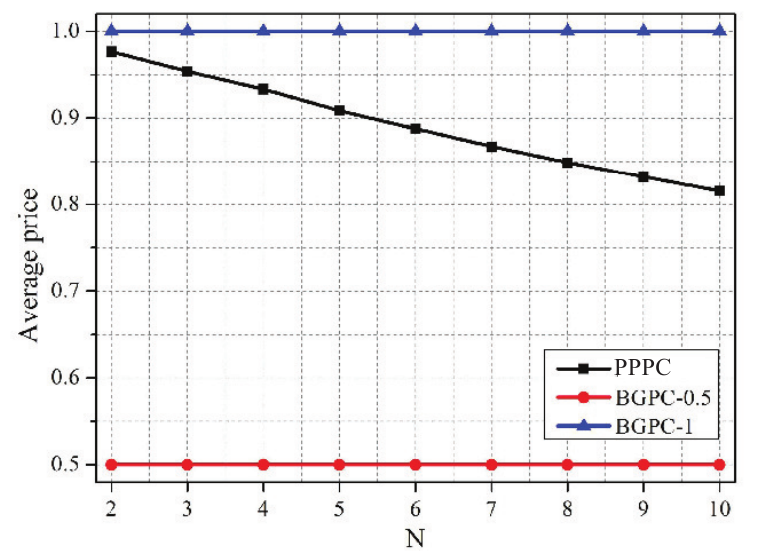
Figure 9. Average prices vs. N under schemes with different pricing mechanisms. BGPC, Bayesian game mode-based power control.